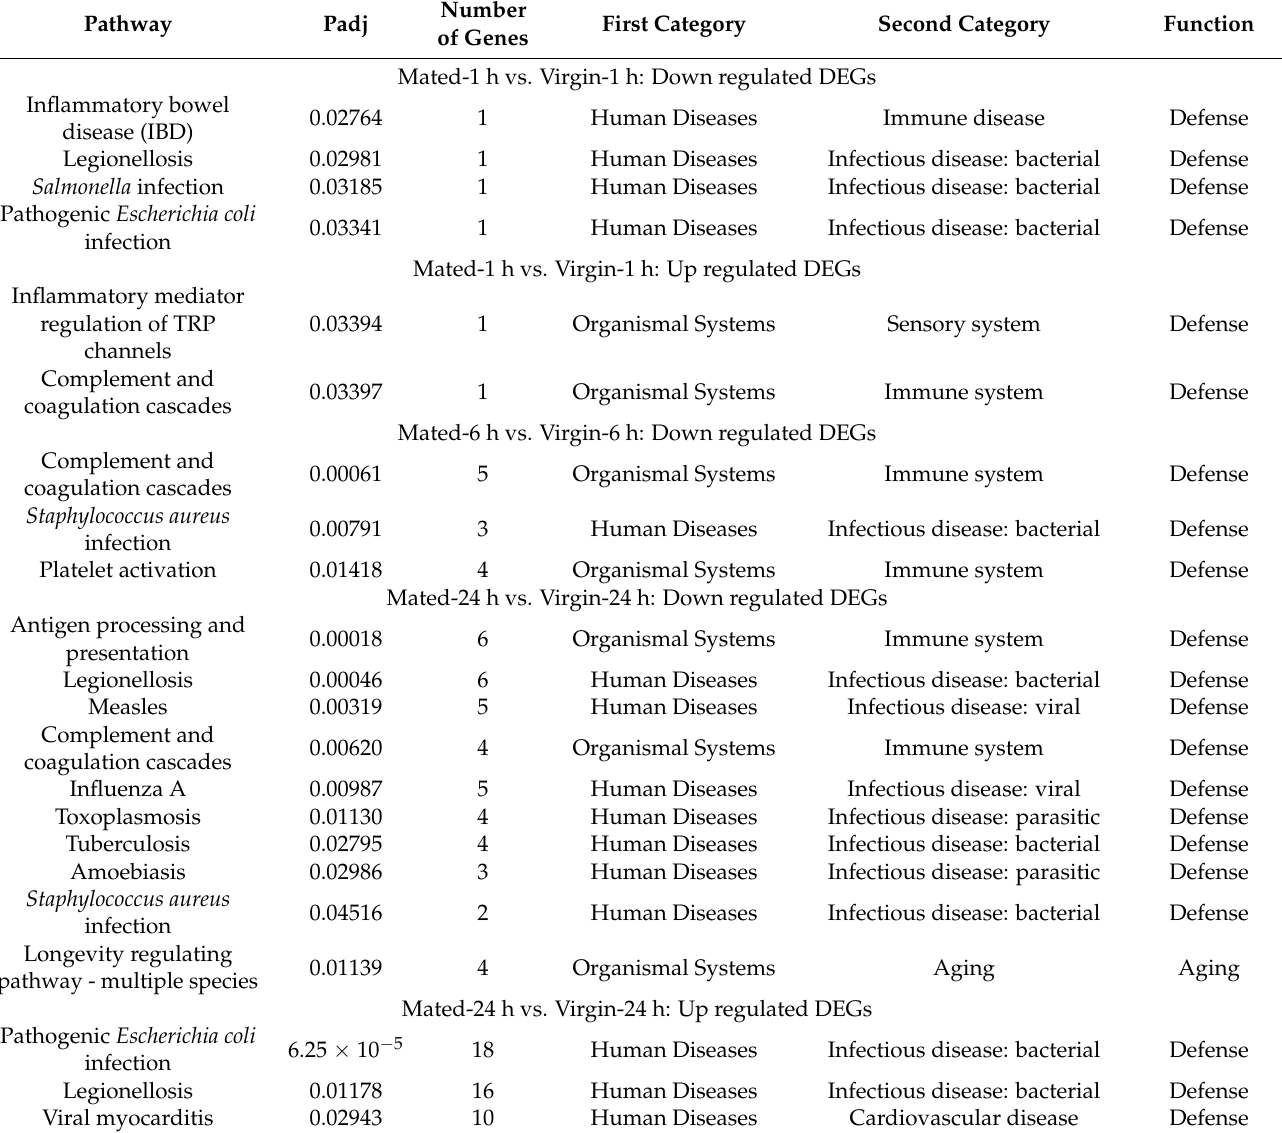
Table 4. Survivorship related KEGG pathways enriched in DEGs of C. chuxiongica